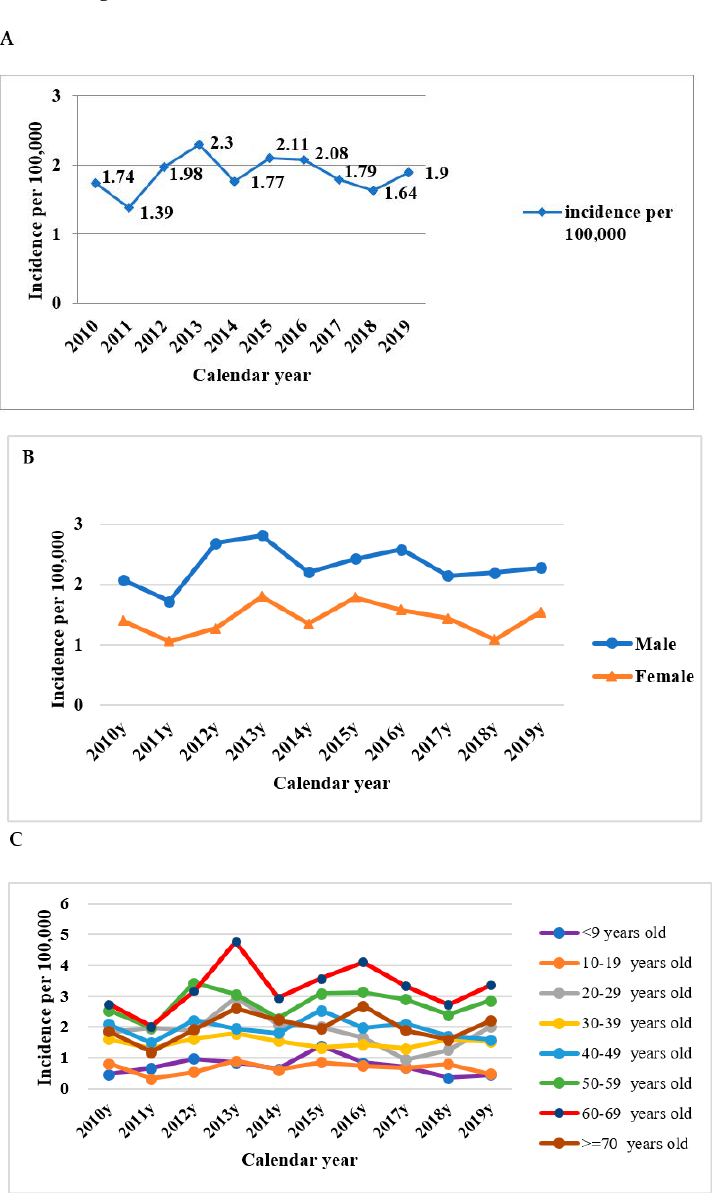
Figure 1. Incidence of confirmed scrub typhus among patients in Taiwan according to ( A ) population, ( B ) sex and ( C ) age by year from 2010 to 2019.